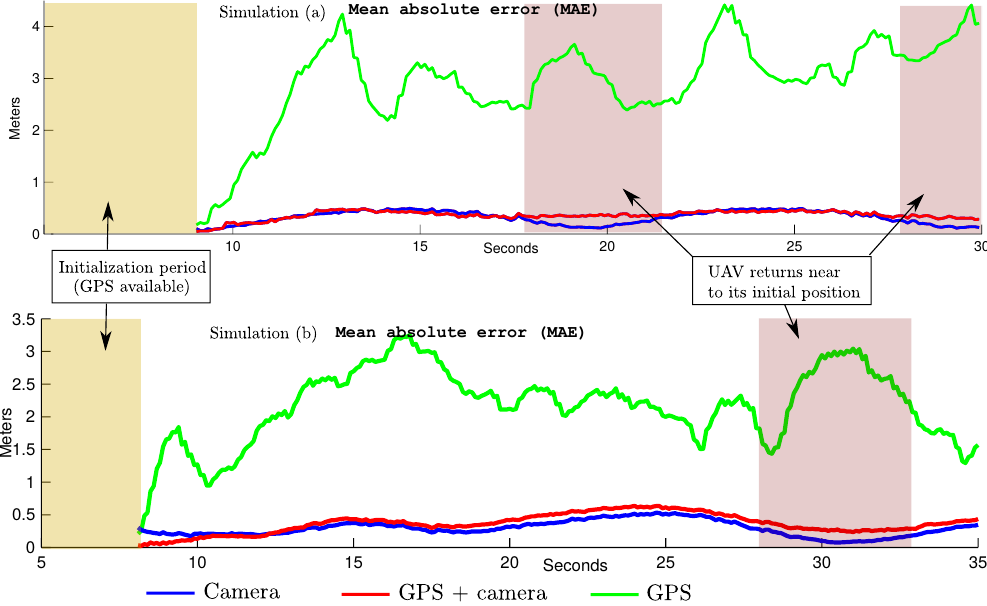
Figure 10. Mean absolute error (MAE) in position computed from two simulations (a and b) out of 20 Monte Carlo runs: ( upper plot ) simulation (a) results; ( lower plot ) simulation (b)